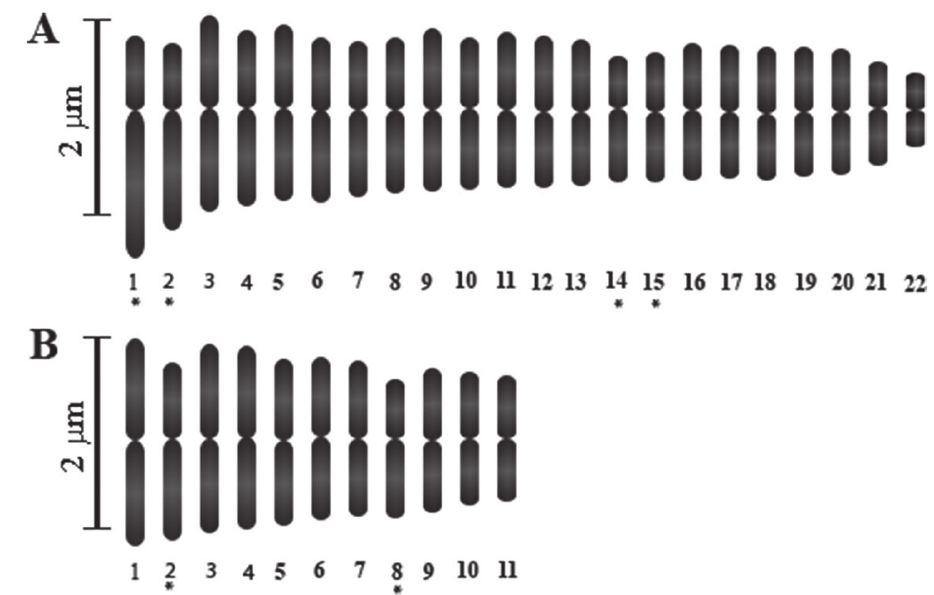
Figure 4. Idiograms of tetraploid ( A ) and diploid ( B ) cytotypes of the columnar cactus Pachycereus pringlei. Asterisk ( * ) denotes submetacentric